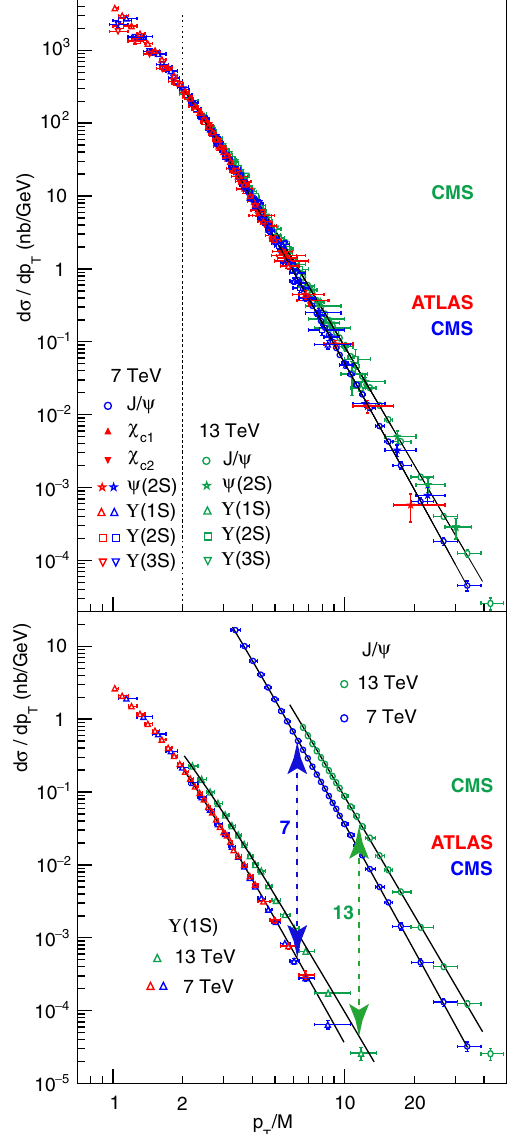
Fig. 3 Shapecomparisonbetweenthe7and13TeV p T / M -differential quarkoniumcrosssections(top)andnormalizationcomparisonbetween the J /ψ and Υ (1S) at the two energies (bottom)